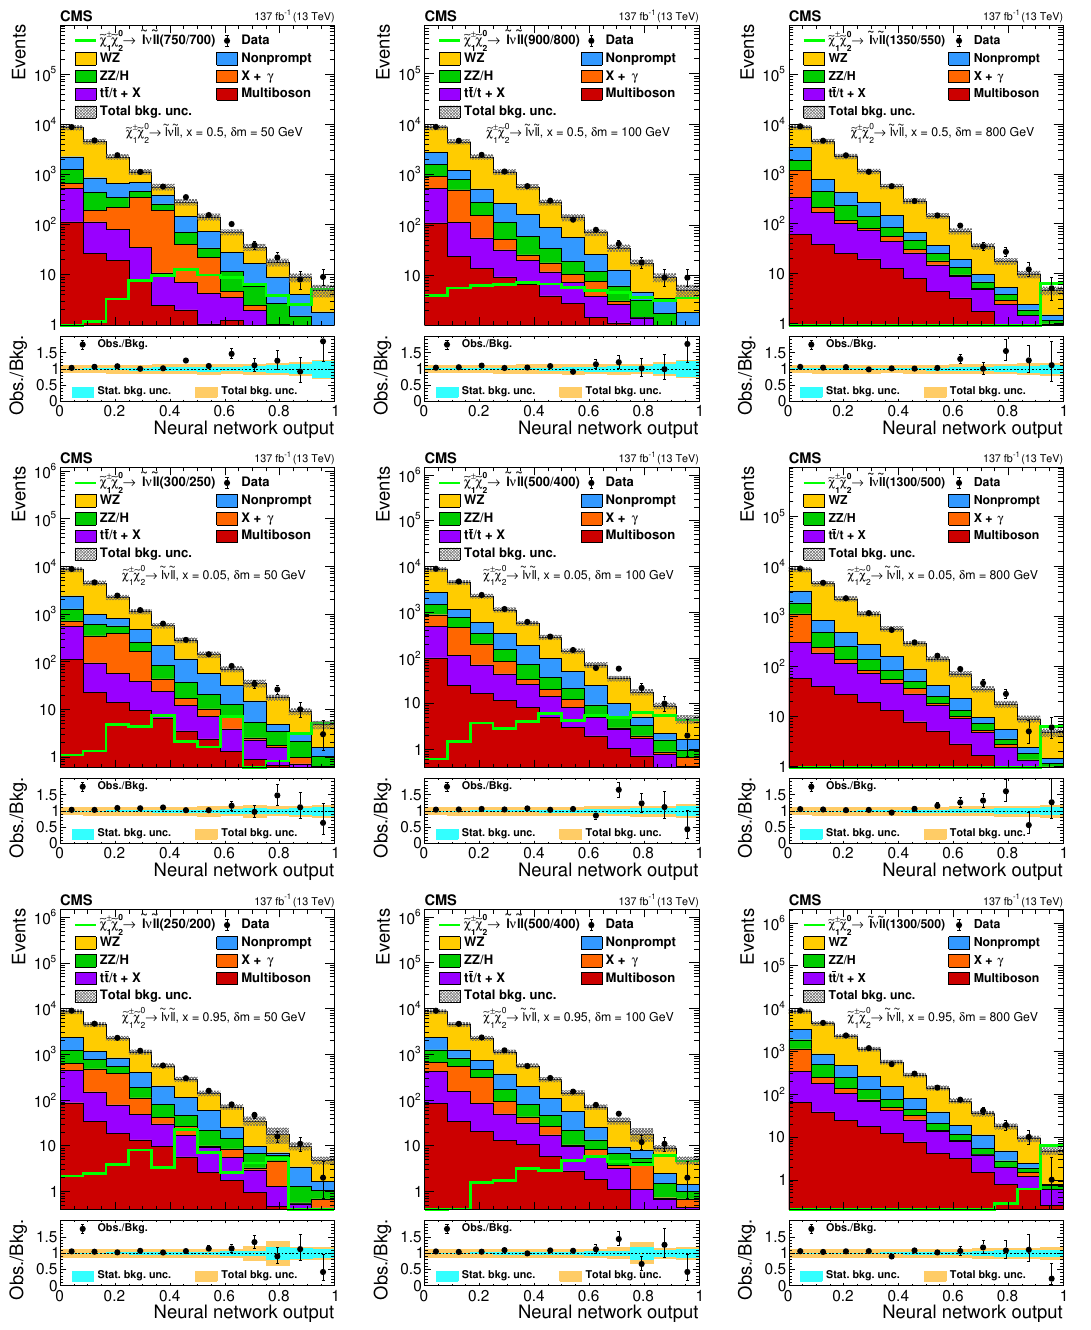
Figure 6 . Observed and expected yields as functions of the output of the neural network used to ± 0 search for production with slepton-mediated decays at x = 0 . 5 (upper), 0 . 05 (middle), and e c 2 1 e c 0 . 95 (lower), evaluated at δm = 50 GeV (left), 100 GeV (center), and 800 GeV (right). The legends 0 0 specify the masses of and for the shown signal distributions as ( m e c e c 2 1